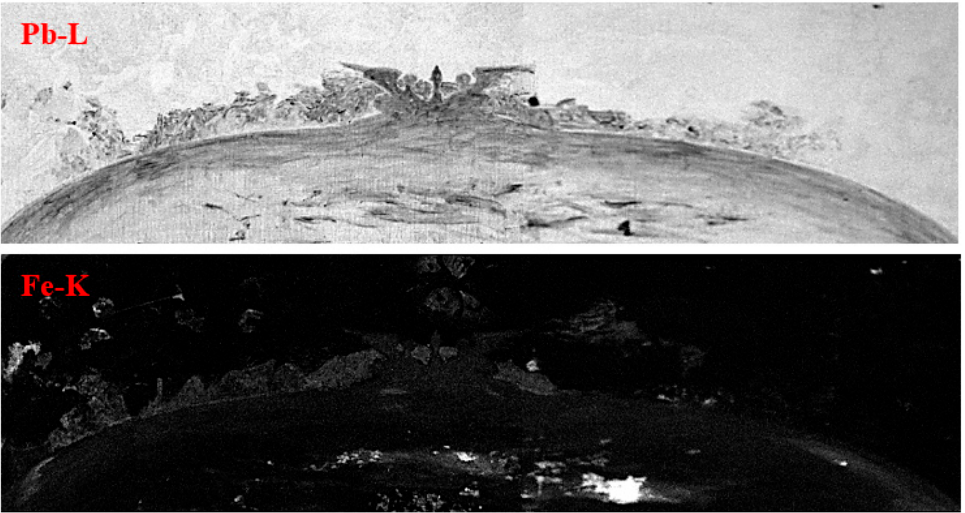
Figure 8. Elemental maps Pb-L and Fe-K of painting “ A poesia e o amor afastando a virtude do vício ” by Eliseu Visconti.